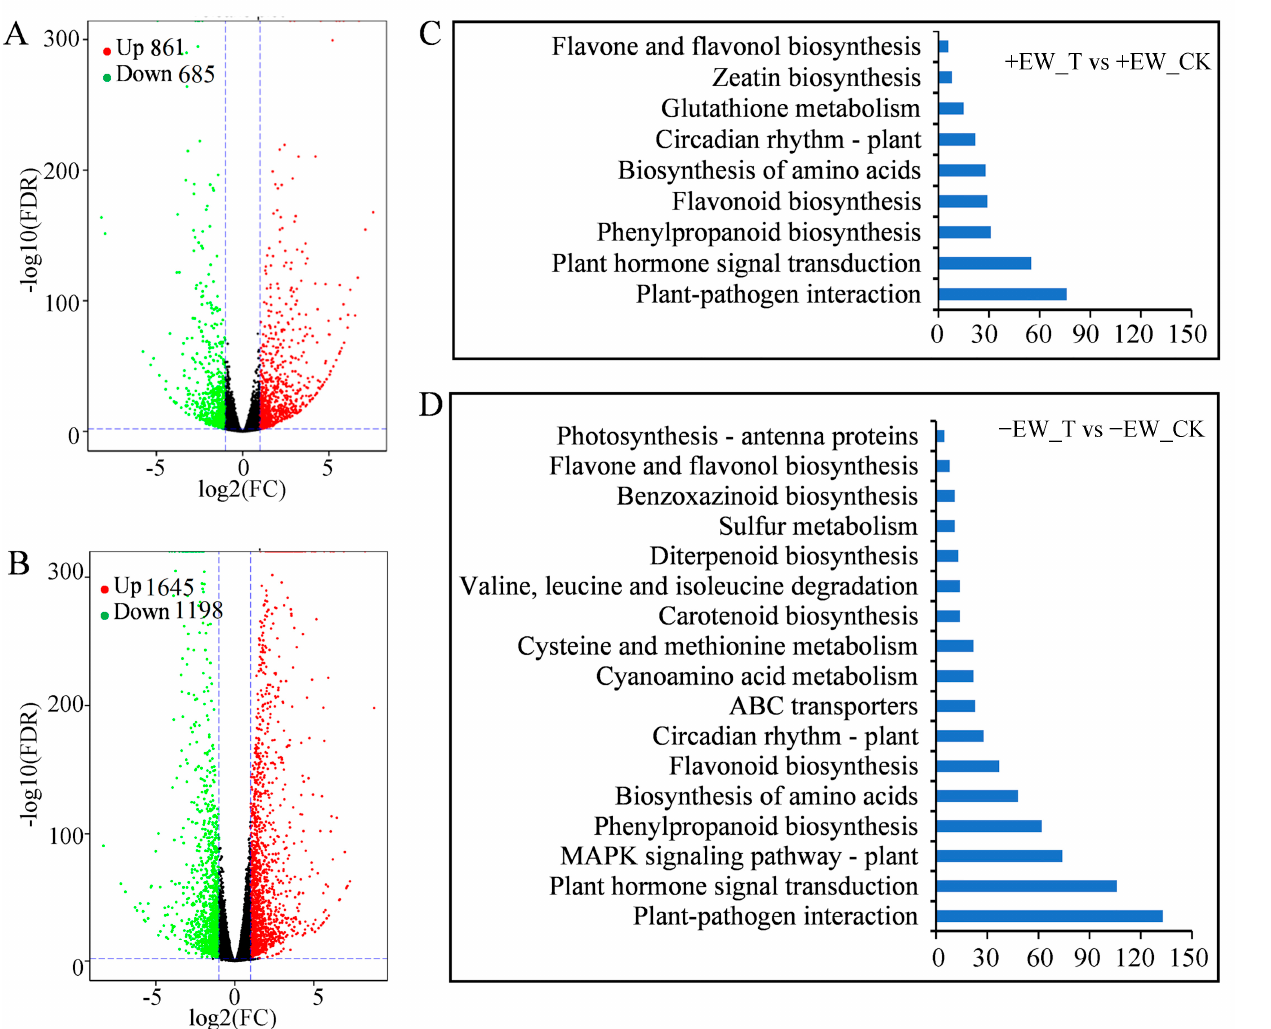
Figure 5. DEGs and their significantly enriched KEGG pathways of sorghum leaves to anthracnose infection. Volcano plot showing the DEGs from plants with epicuticular wax ( A ) and plants without epicuticular wax ( B ). Green represents downregulated genes and red represents upregulated genes. Significantly enriched KEGG pathways among the DEGs in plants with epicuticular wax ( C ) and removing epicuticular wax ( D ) ( q < 0.05).